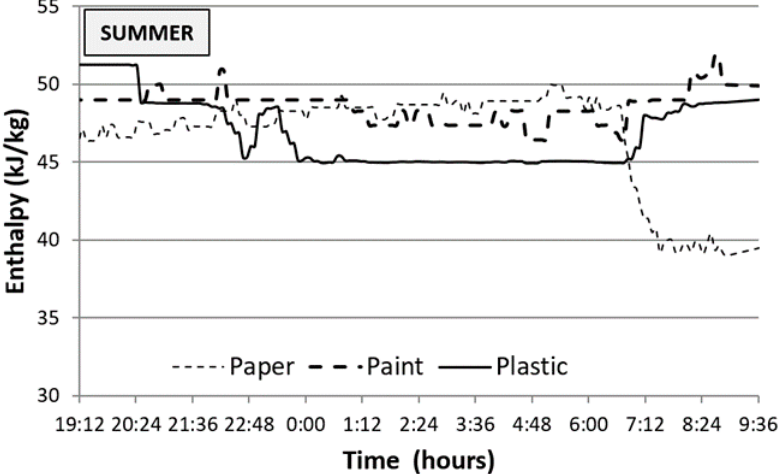
Figure 11. Indoor air percentage of dissatisfied persons (PD IAQ ) predicted for each internal covering during the summer season.